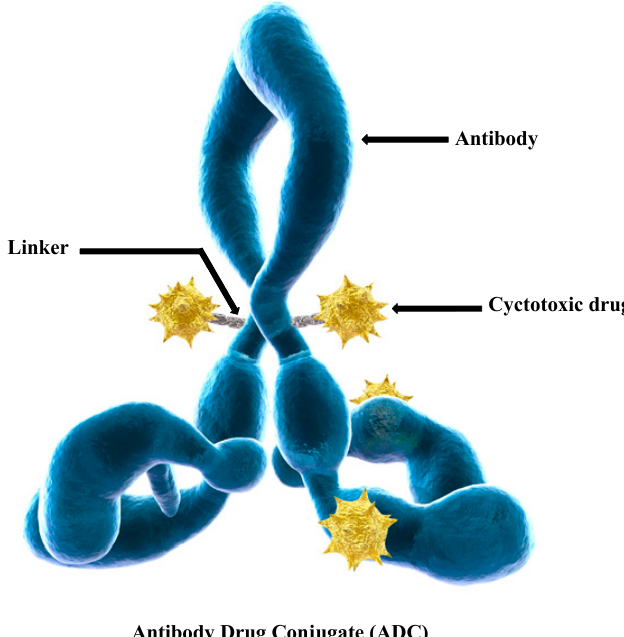
Figure 1. Schematic for the structure of an antibody–drug conjugate (ADC). Adapted from reference [6].